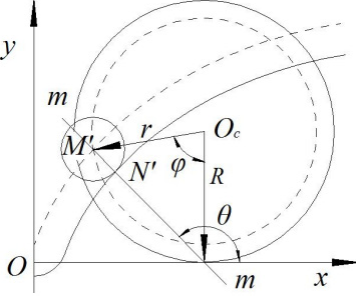
Figure 4. Schematic diagram of the formation of trochoid rack tooth profile.